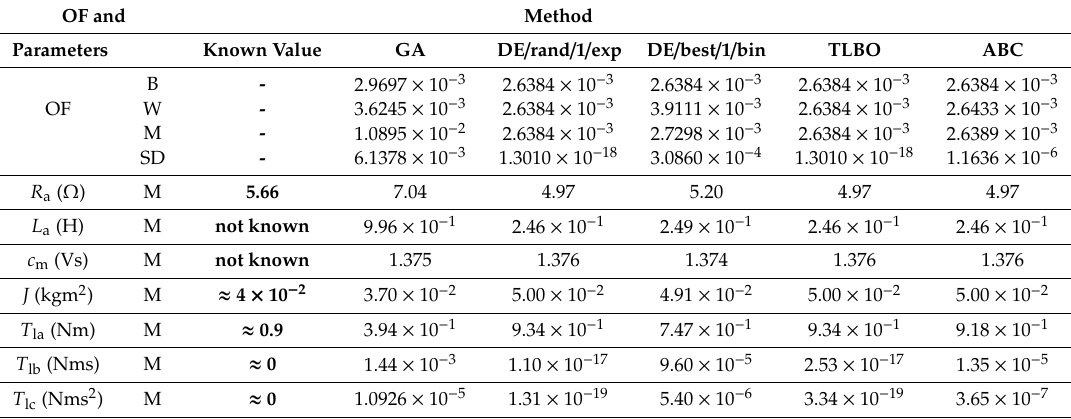
Table 12. OF and Mean value of the calculated parameters for 50 independent runs using RK for MD2. OF and Method